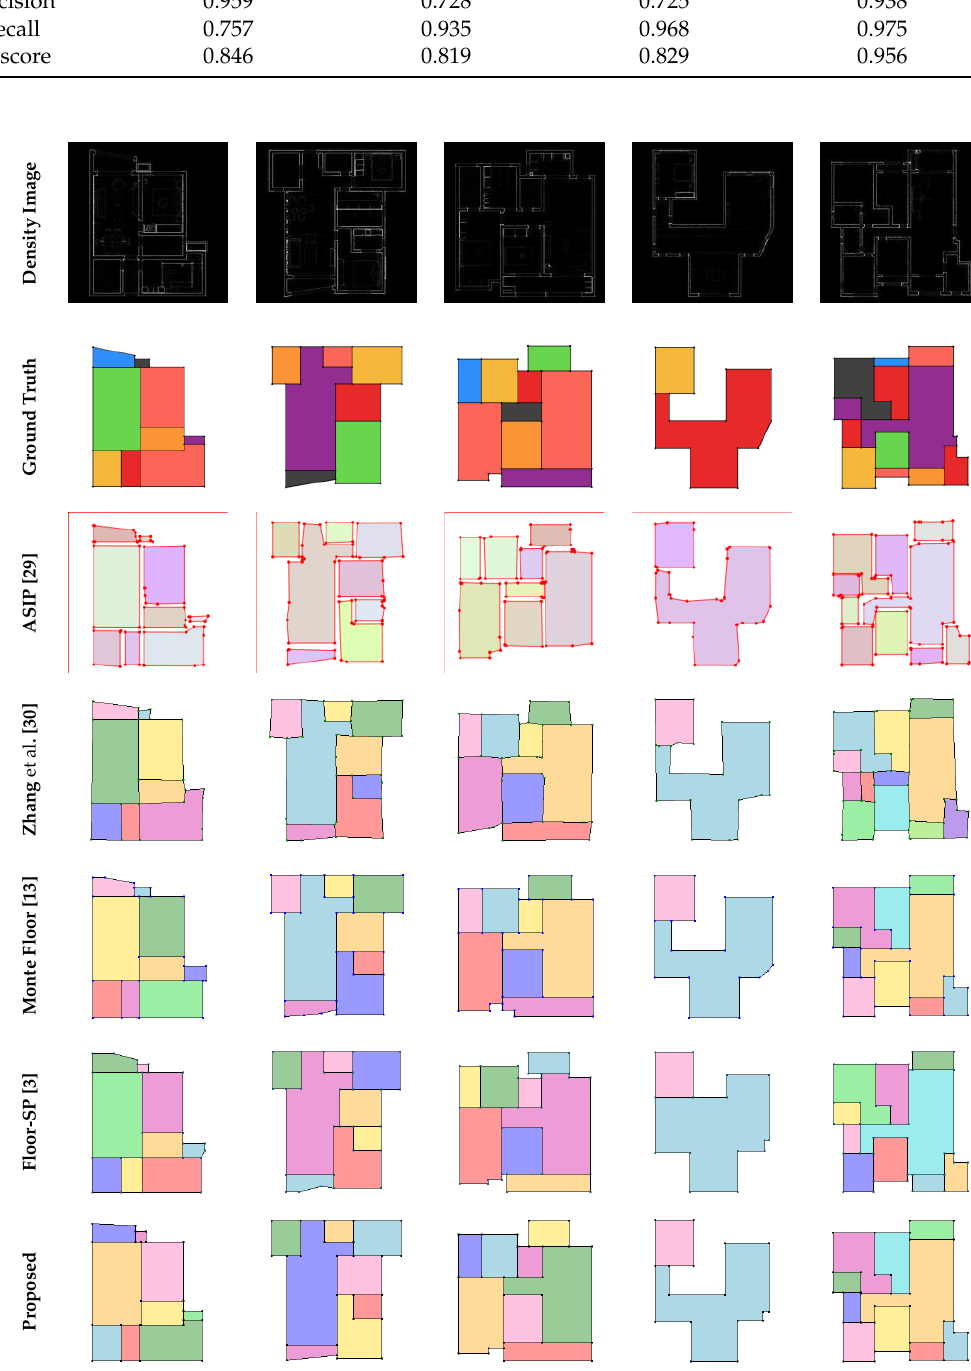
Figure 9. Qualitative comparisons against ASIP, Zhang et al., MonteFloor, and Floor-SP. Table 1. Test results for different mask generation methods.